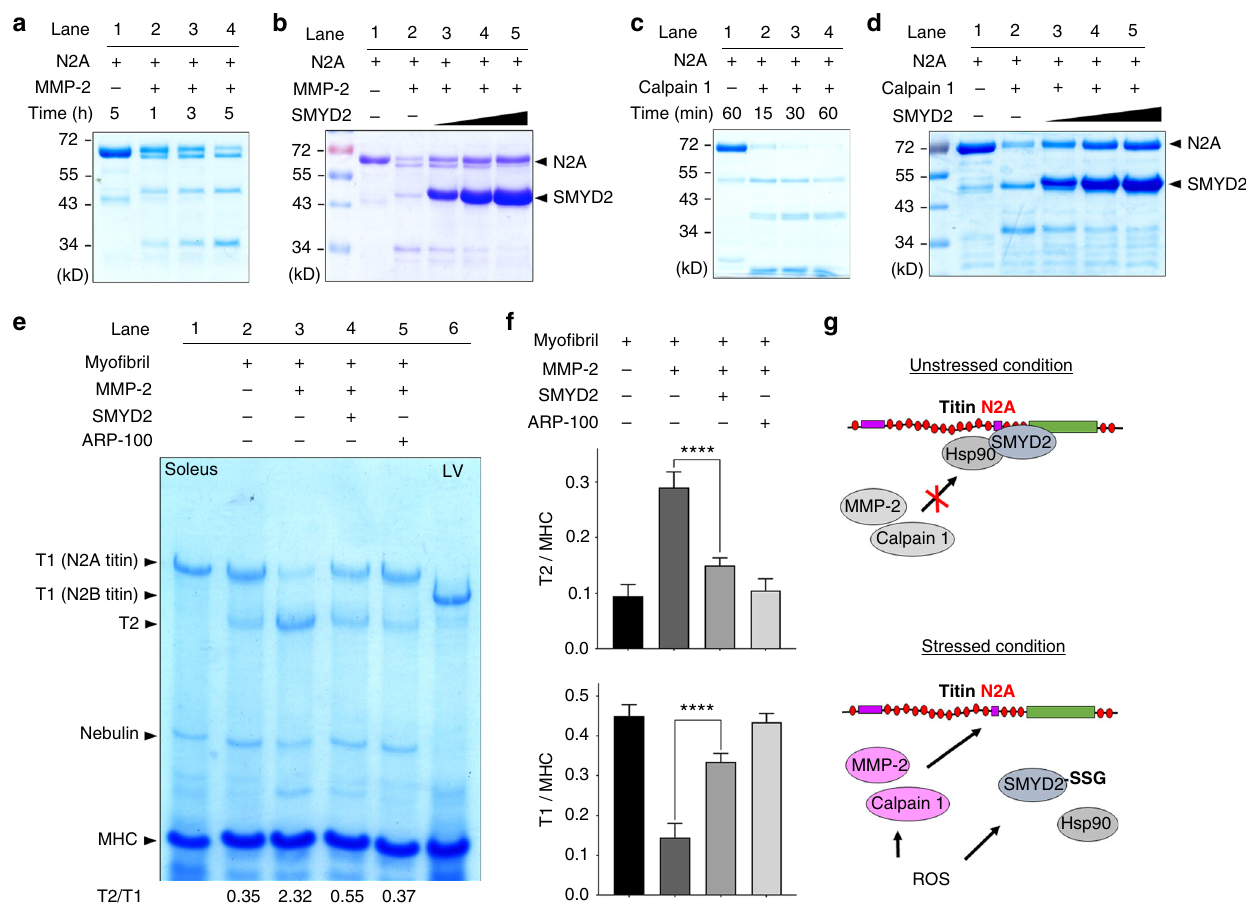
Fig. 7 SMYD2-N2A dissociation contributes to degradation of sarcomeric proteins. a , b N2A is degraded by MMP-2, and SMYD2 protects N2A from degradation. Puri fi ed N2A was incubated with active MMP-2 in a time-dependent manner ( a ) or with an increasing amount of SMYD2 ( b ). c , d N2A is degraded by calpain 1, and SMYD2 protects N2A from degradation. Puri fi ed N2A was incubated with calpain 1 in a time-dependent manner ( c ) or with an increasing amount of SMYD2 ( d ). Data are representative of 4 independent experiments. e , f Titin in isolated myo fi brils is degraded by MMP-2, and SMYD2 protects titin from degradation. Myo fi brils isolated from mouse gastrocnemius muscle were incubated with active MMP-2 in the absence and presence of SMYD2 ( e ). Extracts of soleus muscle and left ventricle (LV) isolated from 6.5-months old rat were used as standards (lane 1 and lane 6). Levels of titin degradation by measuring the ratio of T1 or T2 to MHC ( f ). In all conditions, proteins were analyzed by Coomassie stains. Data represent the mean ± SD, n = 3 independent experiments. Difference is signi fi cant by one-way ANOVA followed by Tukey ’ s post-hoc test, * p < 0.05, ** p < 0.01, *** p < 0.001, **** p < 0.0001. g A proposed mechanism of sarcomere destabilization upon SMYD2 glutathionylation or oxidation. Under unstressed conditions, SMYD2-Hsp90 binds with and protects N2A of titin (top). Under stressed conditions, ROS lead to activation of MMP-2 and calpain 1 while inducing glutathionylation (or other oxidations) of SMYD2, which is then dissociated from N2A or titin, allowing for sarcomeric protein degradation by MMP-2 and calpain 1. It remains to be analyzed how SMYD2 glutathionylation or oxidation contributes to degradation of α -actinin and troponin I isoform. 46 Incubation of fresh myo fi brils with active MMP-2 induced degradation of titin, decreasing the level of N2A-titin (T1) while increasing the level of T2 (Fig. 7e, lane 2 vs. 3, and Fig. 7f). Notably, incubation of SMYD2 protected titin from MMP-2 mediated degradation (Fig. 7e, lane 3 vs. 4, and Fig. 7f). Titin degradation was also inhibited upon an addition of ARP-100 (Fig. 7e, lane 3 vs. 5, and Fig. 7f). In these experiments, there was no apparent degradation of MHC (Fig. 7e). Overall, these data support our model that the SMYD2 binding interaction with N2A, titin, or sarcomeric proteins confers the protection against proteases, whereas SMYD2 dissociation upon glutathionylation or oxidation contributes to degradation of sarcomeric proteins (Fig. 7g).